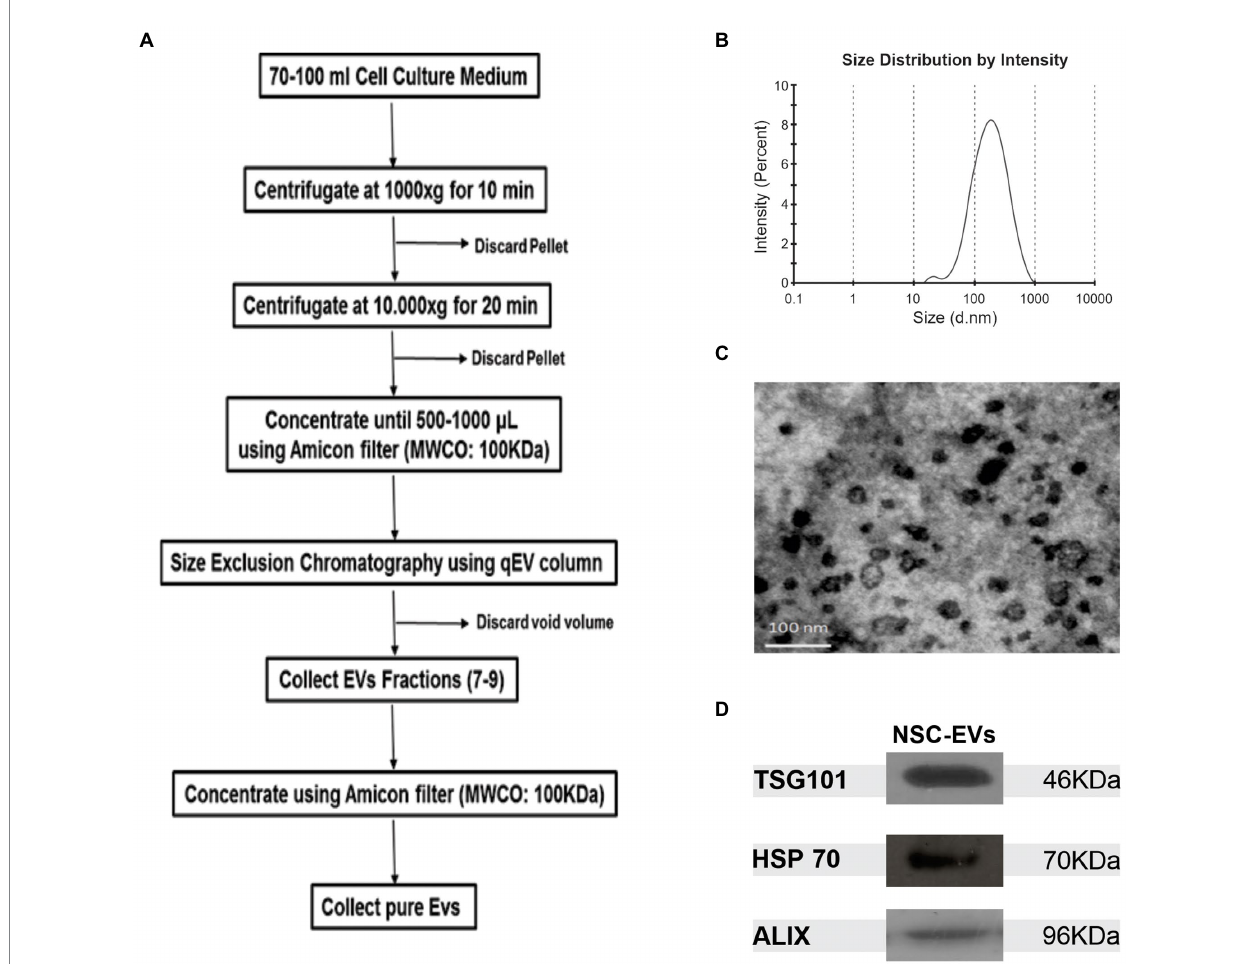
FIGURE 1 NSCs-EV purification and characterisation. (A) Protocol to purify NSC-EVs by sequential centrifugation and size exclusion chromatography. (B) Size distribution of NSC-EVs measured by DLS. (C) Representative image of electron micrograph of purified NSC-EVs. (D) Representative image of